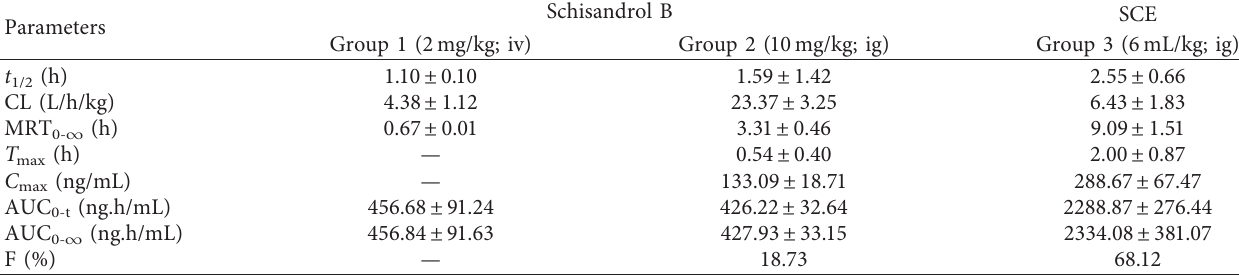
Figure 3: Mean plasma concentration-time curves for Schisandrol B following the intravenous administration of 2mg/kg of monomer (a), the intragastric administration of 10mg/kg monomer (b), and the intragastric administration of 6mL/kg SCE (equivalent to 15mg/kg of Schisandrol B monomer) Table 5: Pharmacokinetic parameters of Schisandrol B in rat plasma.